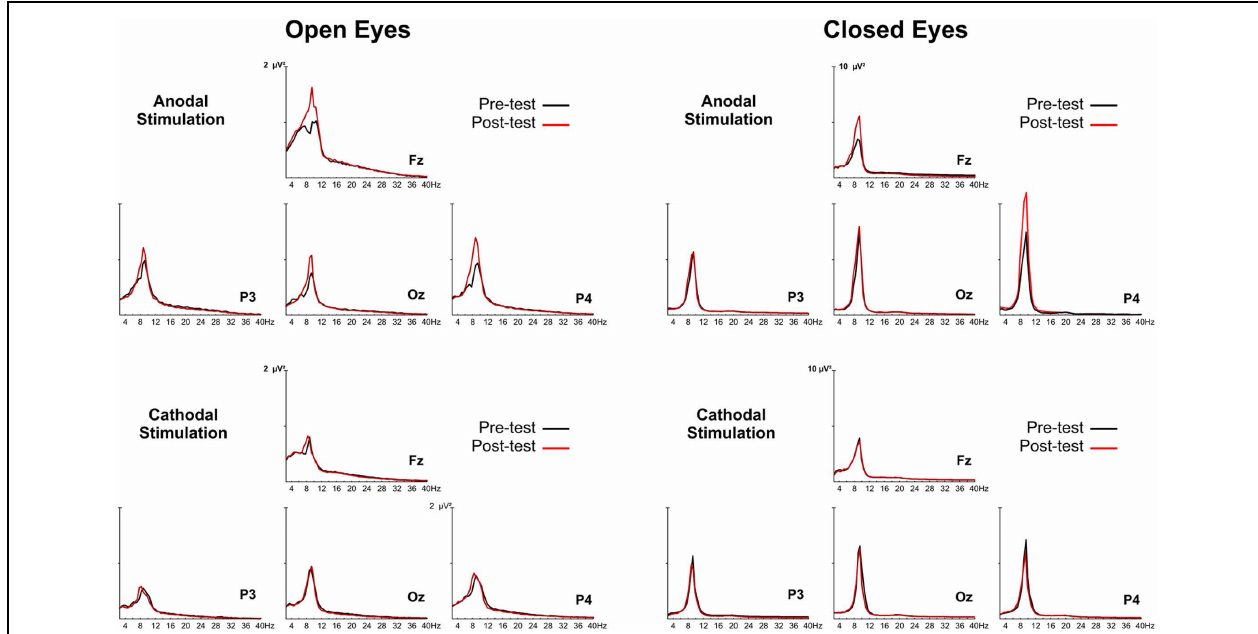
FIGURE 2 | Group grand-averaged EEG spectra of anodal and cathodal stimulation with the eyes open (left panel) and closed (right panel). The black line represents activity before tDCS (pretest), and the red line is activity after tDCS (posttest).